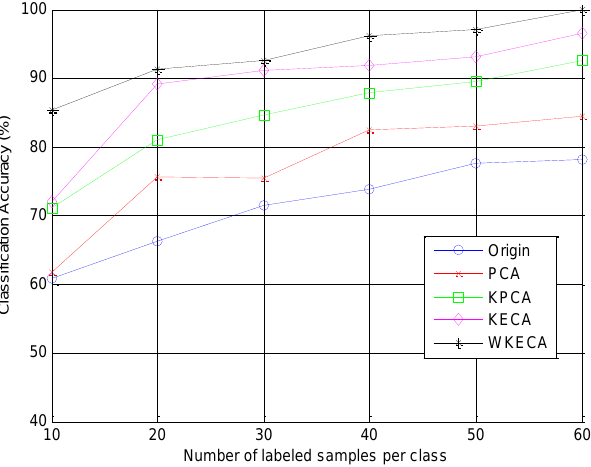
Figure 9. Classification accuracy of SVM based on different feature extraction methods for different labeled samples.